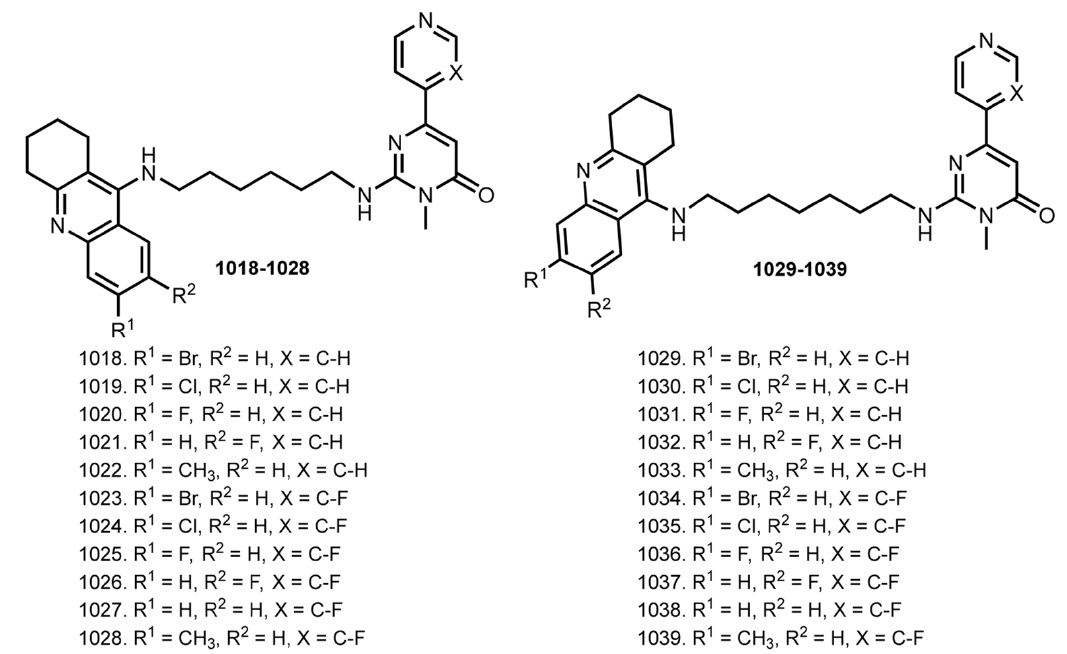
Figure 37. THA—pyrimidone hybrids 990 – 1039 [131]. Br ‐ and Cl ‐ as substituents in THA unit were found to enhance AChE inhibition, flu ‐ orine ‐ substituted pyridine groups were found to intensify to GSK ‐ 3 β target, and alkyla ‐ mine linkers with a linear chain of seven carbons were chosen as the most beneficial moi ‐ ety. Hybrid 1035 was chosen as the compound with excellent dual AChE/GSK ‐ 3 inhibition (AChE: IC 50 51.1 nM; GSK/3 β : IC 50 89.3 nM).